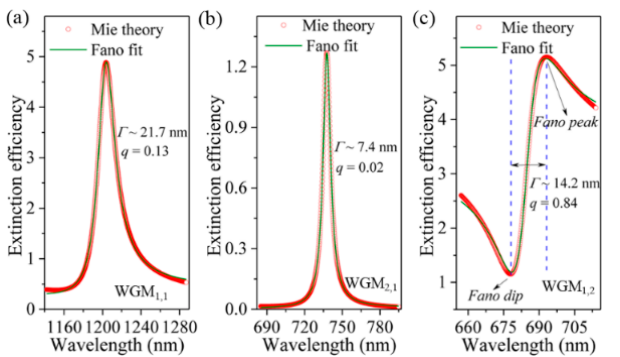
Figure 4. Fano fitting (olive lines) for the FRs induced by WGM 1,1 ( a ), WGM 2,1 ( b ) and WGM 1,2 ( c ), respectively. The red lines display the calculated extinction efficiency spectra.